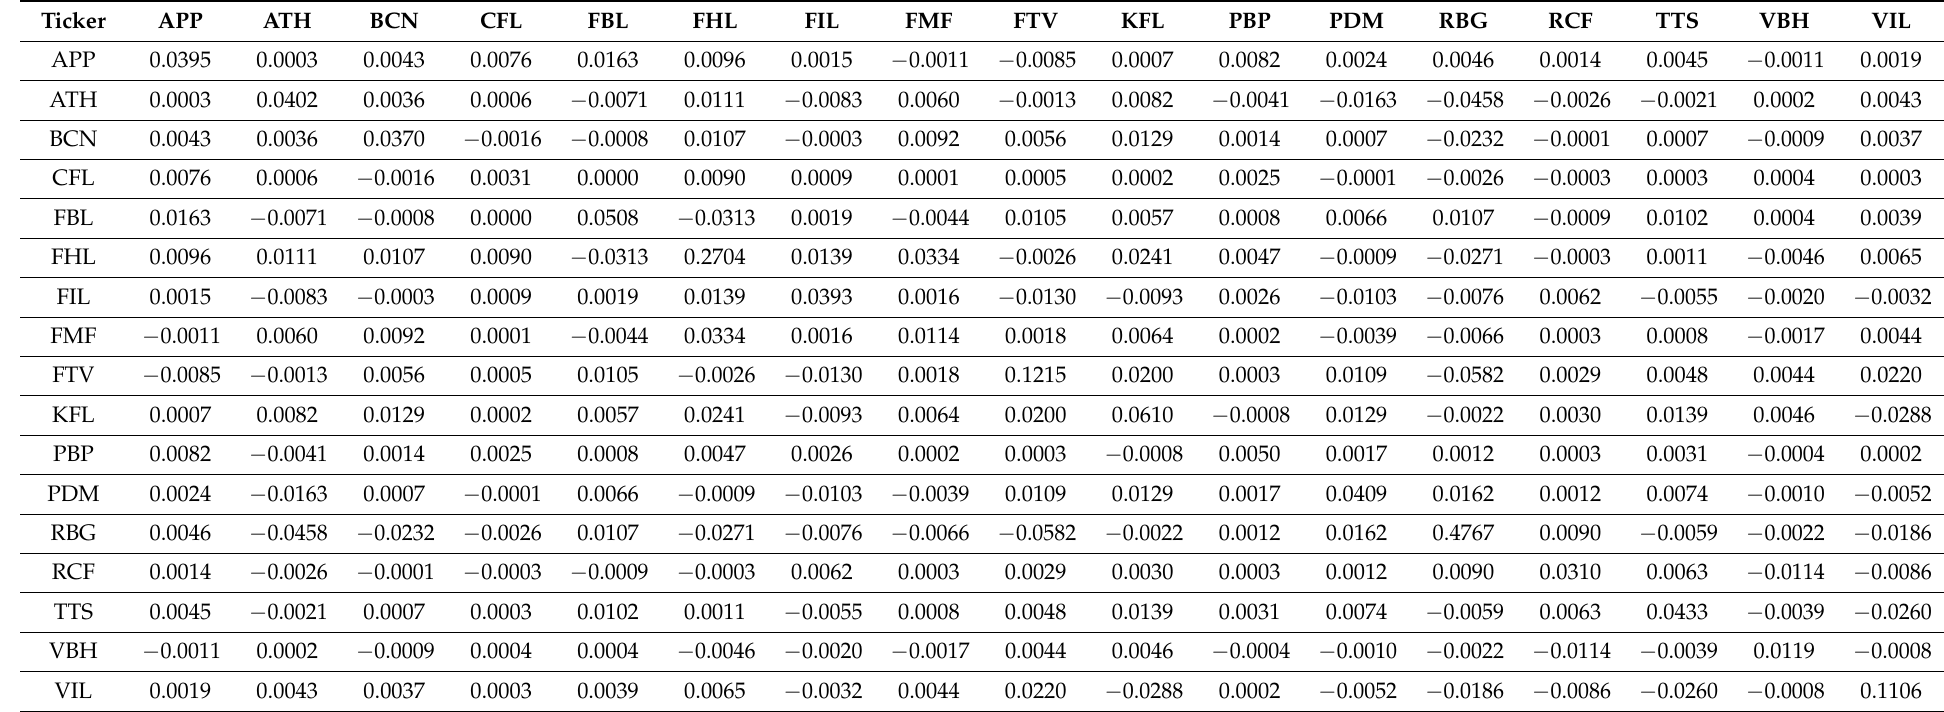
Table 2. Covariance matrix